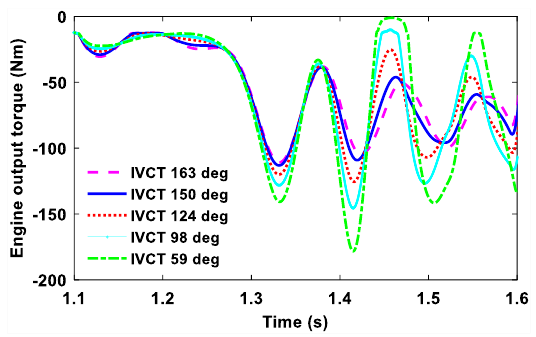
 = 85 deg. Figure 10. Effect of IVCT on engine output torque with θ ica = 85